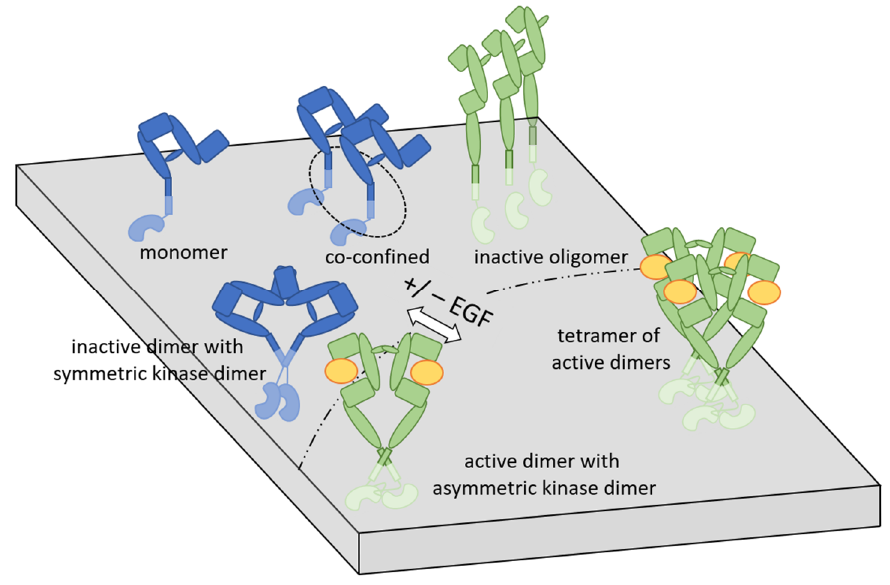
Figure 2. Model of how clustering contributes to the regulation of EGFR. In the absence of EGF (orange oval), the extracellular part of the EGFR adopts a closed conformation (blue-colored objects) and is either monomeric or forms different kinds of preformed clusters. Some of these associations arise as a result of the co-confinement of monomeric receptors in the vicinity of each other. The receptor proteins in these loose associations are unlikely to interact with each other, but this cluster type predisposes them to form direct molecular associations. Unliganded EGFRs with their ECD in the closed conformation can form dimers in which the C-terminal dimerization motif of the TMD (close to the intracellular leaflet of the plasma membrane) interact, and the kinases form an inactive, symmetric dimer. Ligandless EGFR can also undergo oligomerization with the ECD in the extended conformation (displayed in green), and the KDs are positioned in a way that prevents their interac- tion. Upon EGF challenge, the extended conformation of the ECD is stabilized, and the exposed dimerization arms lead to the formation of back-to-back dimers of the ECD, which brings the N- terminal dimerization motifs of the TMD into close proximity and results in the formation of asym- metric KD dimers capable of activation. Such back-to-back dimers most likely undergo oligomeri- zation in order to enable phosphorylation of the C-terminal regulatory domains (the C-terminal regulatory domains are not shown in the figure).